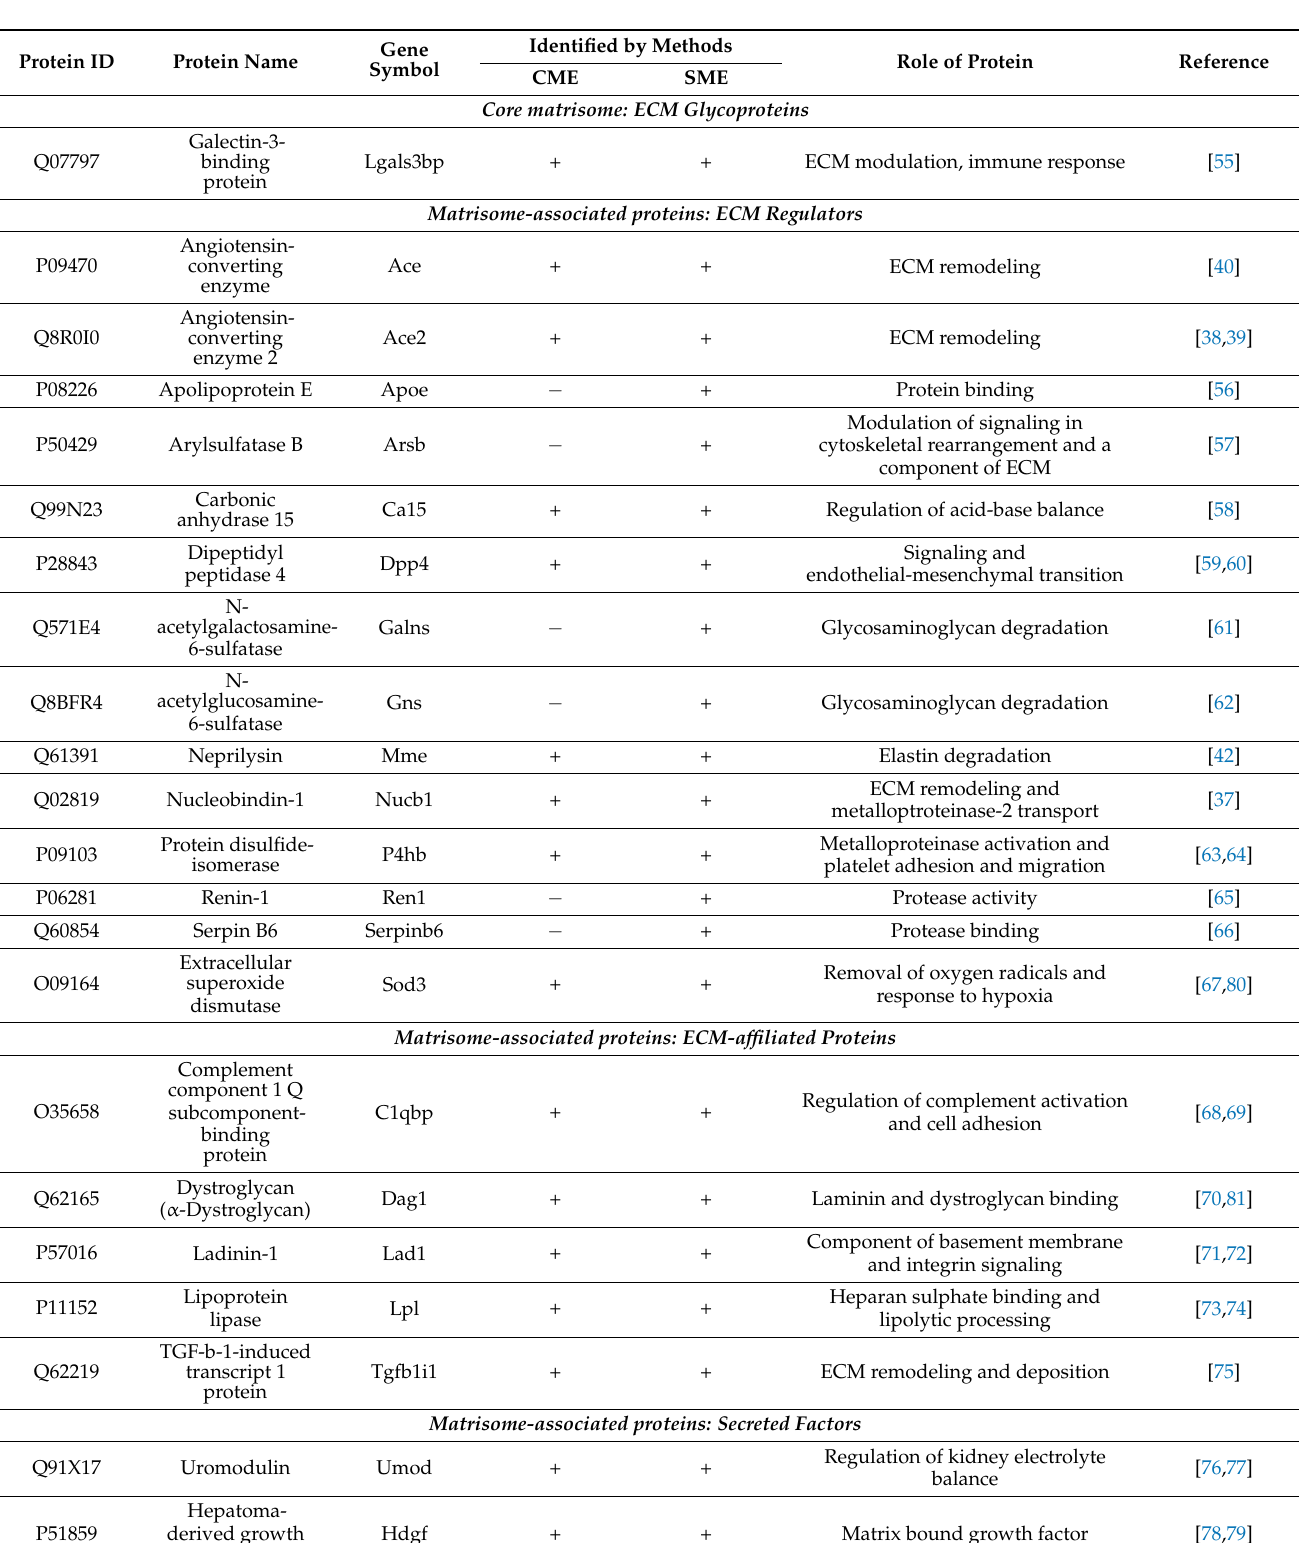
Table A7. Summary of the newly detected and classified mouse kidney matrisome proteins that are not listed in the current Matrisome